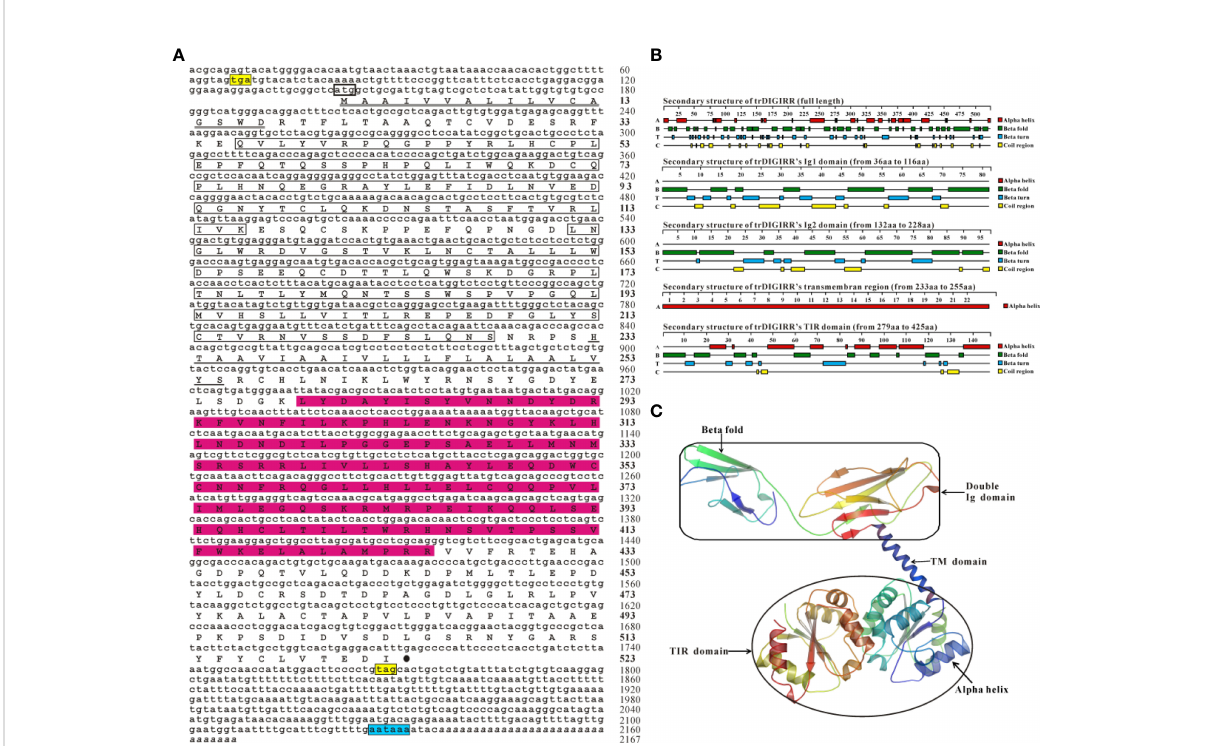
FIGURE 1 The nucleotide and deduced amino acid sequence (A) , secondary structure (B) and 3-D structure (C) of trDIGIRR. (A) The start codon was marked with a thick square, the stop codon was labeled with a black solid circle, the signal peptide was labeled with a double horizontal line, the Ig domain was marked with a square, the transmembrane region was marked with a horizontal line, the TIR domain was marked with a red background, and poly-A tail was italicized. Two in-frame stop condons were marked in yellow and the the polyadenylation signal (aataaa) upstream of the poly (A) tail was marked in blue. (B) The secondary structure of trDIGIRR was predicted using Protean software. (C) The 3-D structure of trDIGIRR was constructed using the SWISS-MODEL